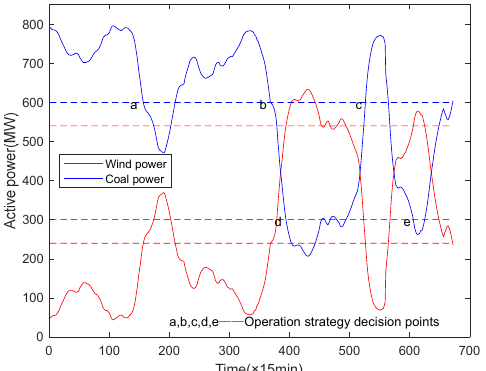
Figure 5. Wind power curve and complementary coal power curve.